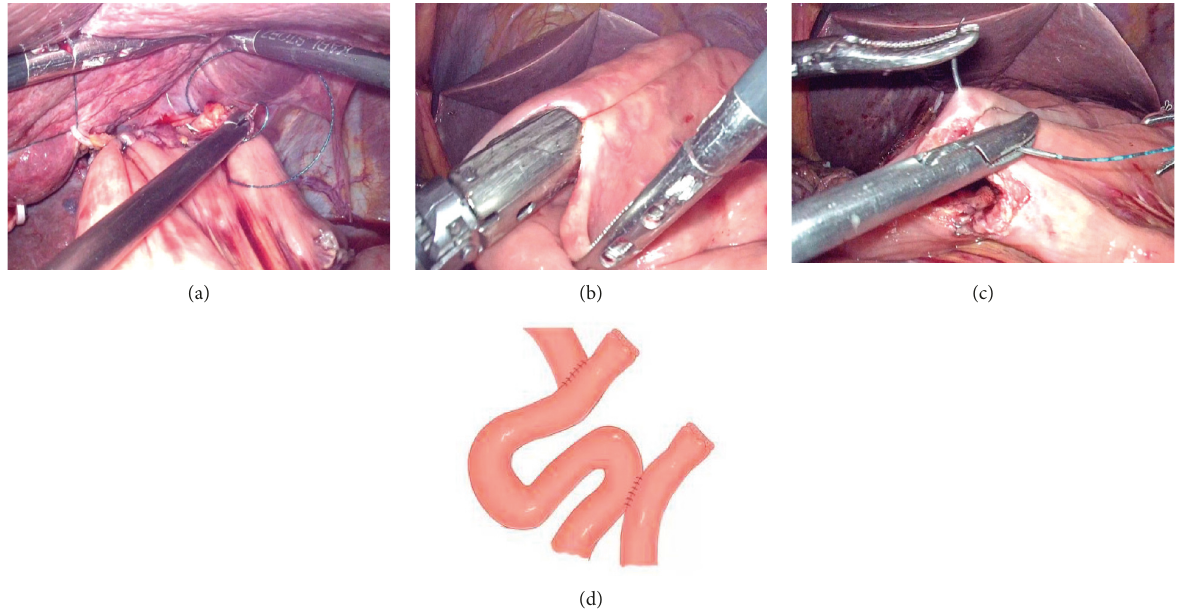
Figure 5: (a) 3-0 barbed wire from right to left for jejunal seromuscular-diaphragmatic suture. (b) The proximal jejunum was anastomosed to the jejunum side at 40cm away from the esophagojejunostomy. (c, d) 3-0 barbed wire sutured to close the common